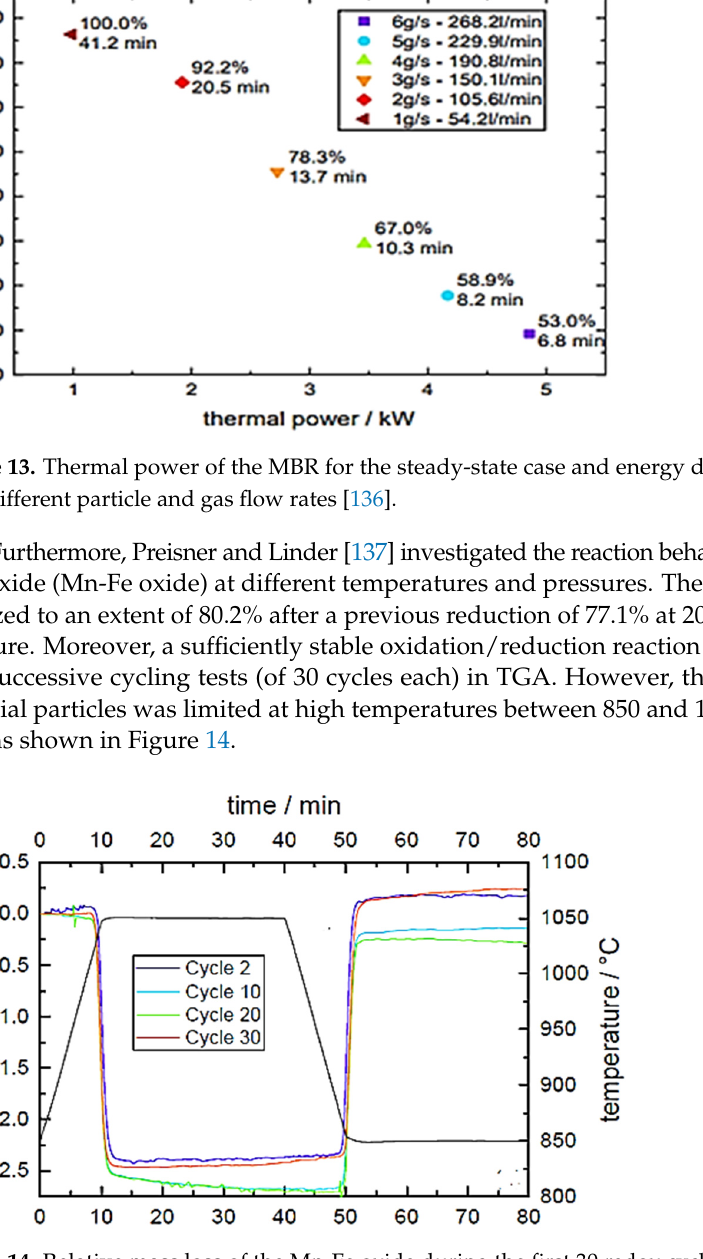
Figure 14. Relative mass loss of the Mn-Fe oxide during the first 30 redox cycles